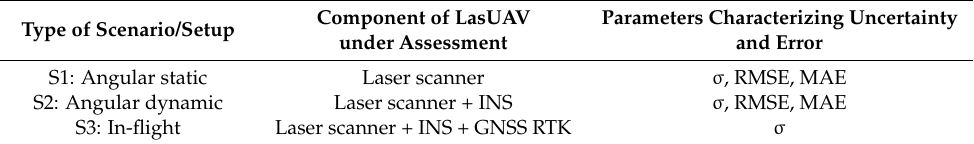
Table 2. Three setups to assess the accuracy of LasUAV components and parameters to characterize uncertainty. RMSE, root mean-squared error; MAE, mean absolute error.